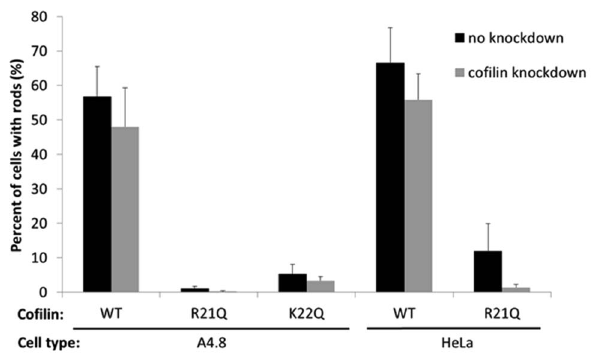
Figure 3. Rod formation in cells overexpressing either cofi- linR21Q-mRFP or cofilinK22Q-mRFP is dramatically reduced compared to expression of cofilin-wt-mRFP. Pig kidney LLC-PK A4.8 cells and HeLa cells were infected with adenovirus for expression of a cofilin shRNA (grey bars) or a control adenovirus (black bars), then 3 days later the cells were transfected or infected with plasmids or adenovirus for expressing cofilin-mRFP chimeras. Two days after this, the cells were ATP-depleted. The percentage of mRFP-positive cells forming rods is shown. Uninfected LLC-PK A4.8 or HeLa cells that are ATP- depleted, fixed and immunolabeled for cofilin contain no rods [22]. Based upon quantification of cofilin on Western blots of cell extracts (data not shown), the silencing in both cell types is . 95%.